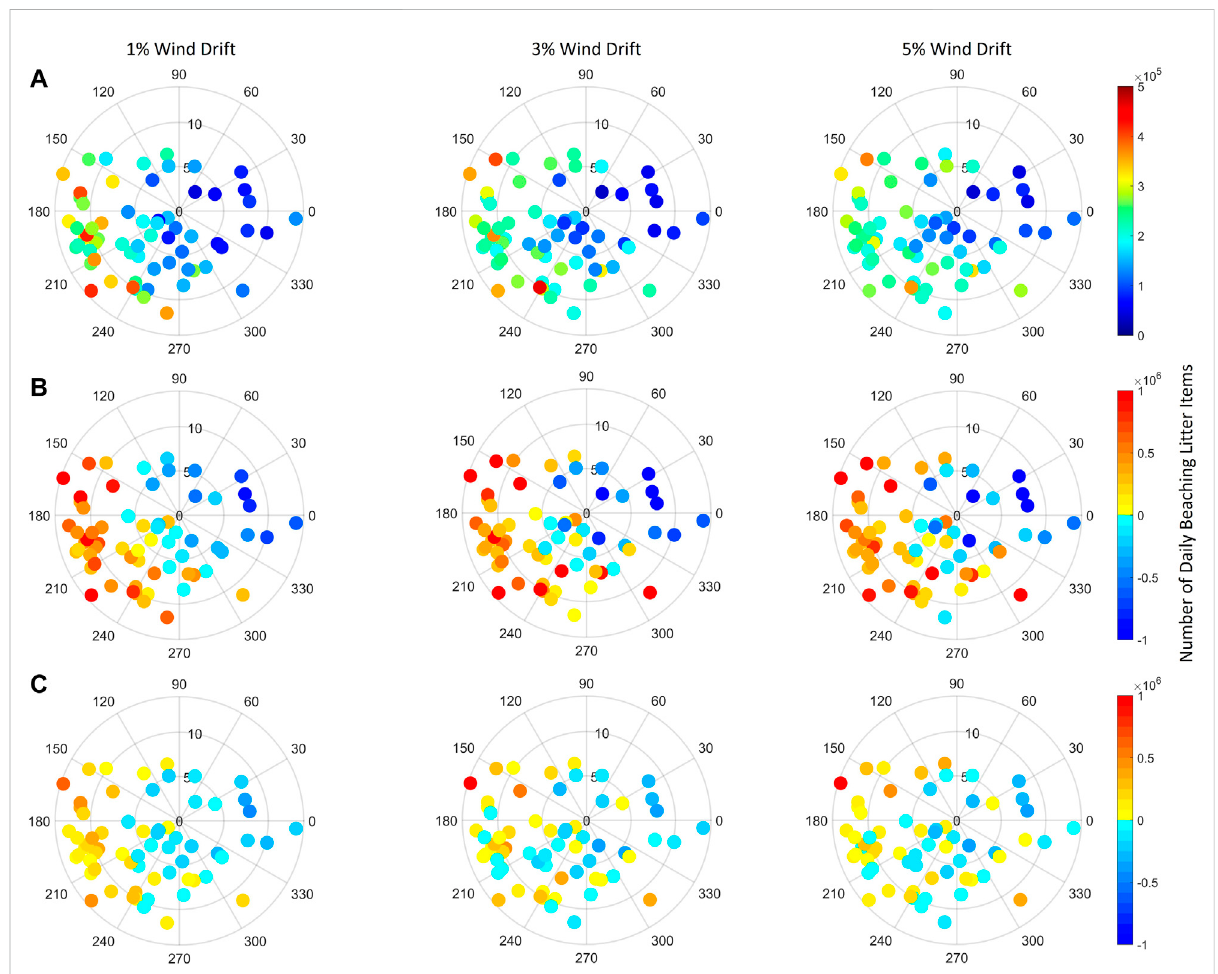
FIGURE 5 Wind Scatter plot of the number of daily beaching plastic litter items within the model sub-area during the steady-state period (day 300 – 365) for the (A) sticky coast boundary condition, (B) resuspending unclassi fi ed coastal boundary condition and (C) resuspending classi fi ed coastal boundary condition. A comparison of the downwind drift as a percentage of the wind speed is displayed for 1%, 3% and